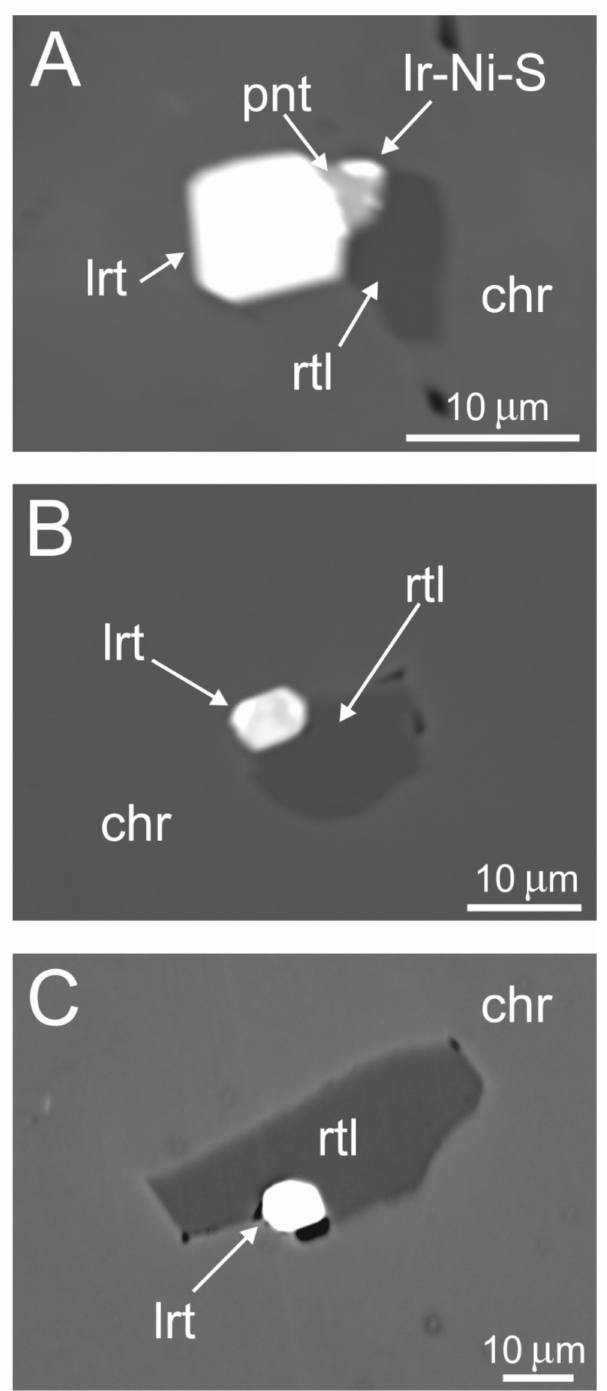
Figure 9. BSE images of rutile-PGM composite inclusions in chromite. Composite grain of rutile, laurite, pentlandite, and Ir-Ni sulfide in fresh chromite of Loma Peguera ( A ). Rutile-laurite composite inclusions in chromite of Nuasahi ( B , C ). Abbreviations: lrt, laurite; others as in Figures 1 and